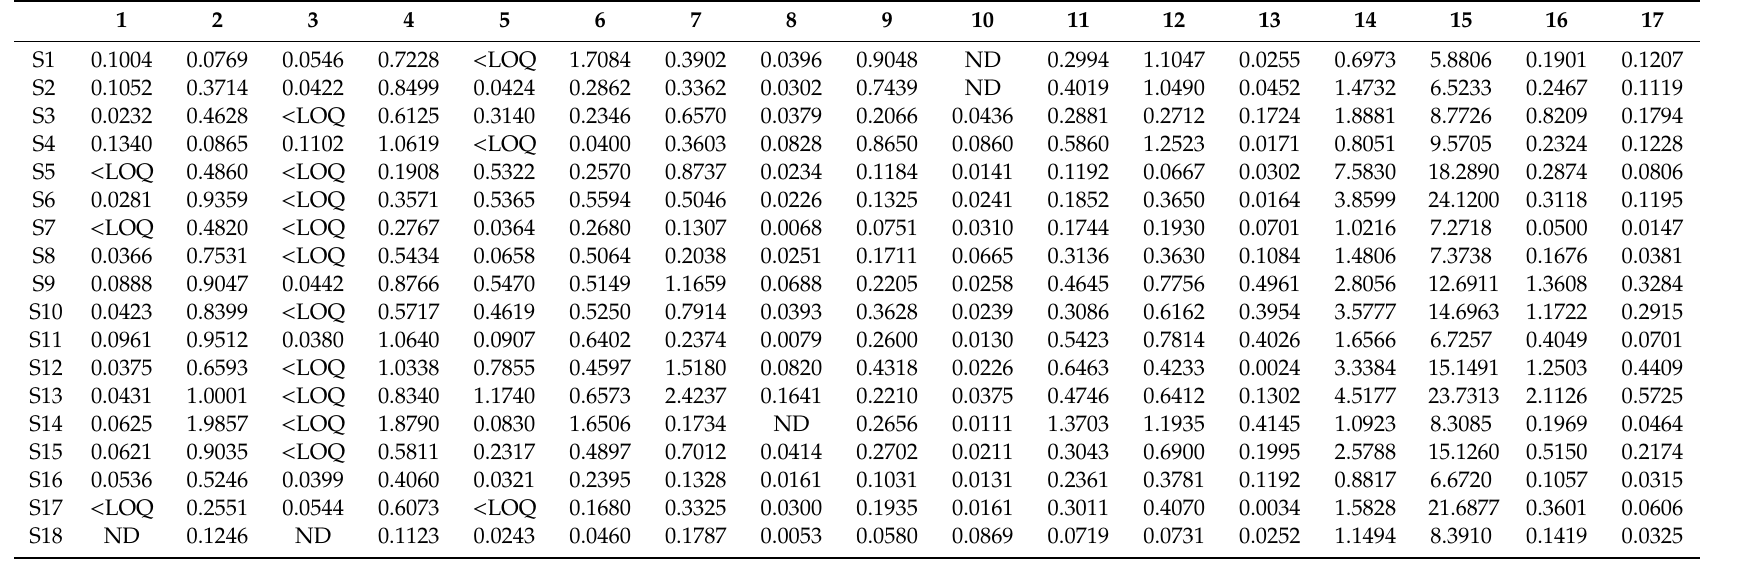
Table 3. Contents of 17 analytes in 18 batches of samples (mg /